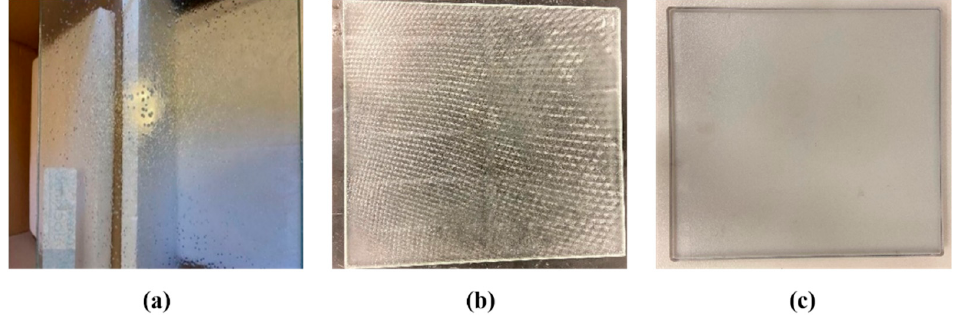
Figure 3. ( a ) Tempered GlassGrit with ( b ) textured 16 mm polycarbonate sheet, and ( c ) textured float